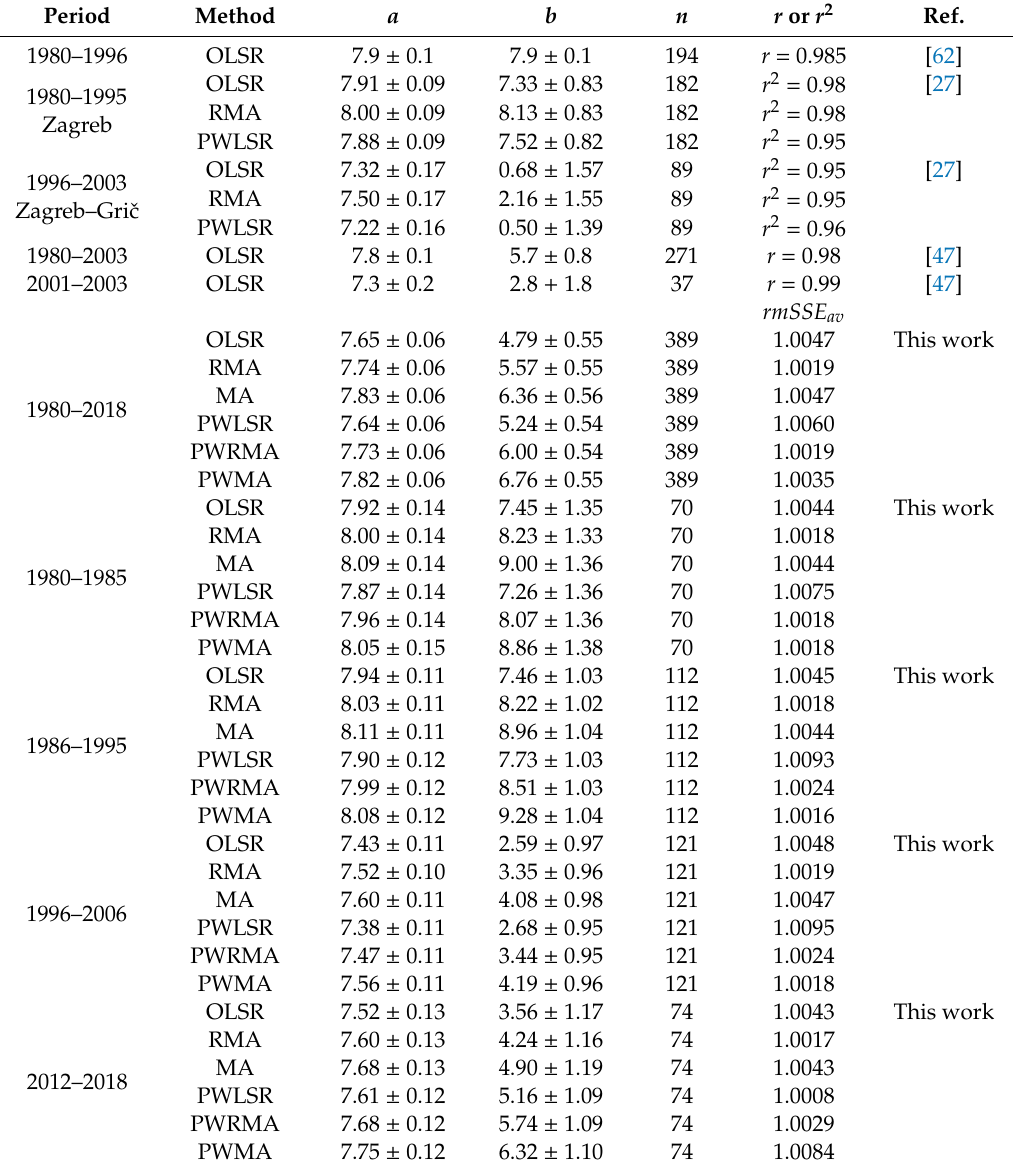
Table 3. Slopes ( a ) and intercepts ( b ) of the local meteoric water line (LMWL) for Zagreb in di ff erent periods and obtained using di ff erent regression methods. OLSR: ordinary least squares